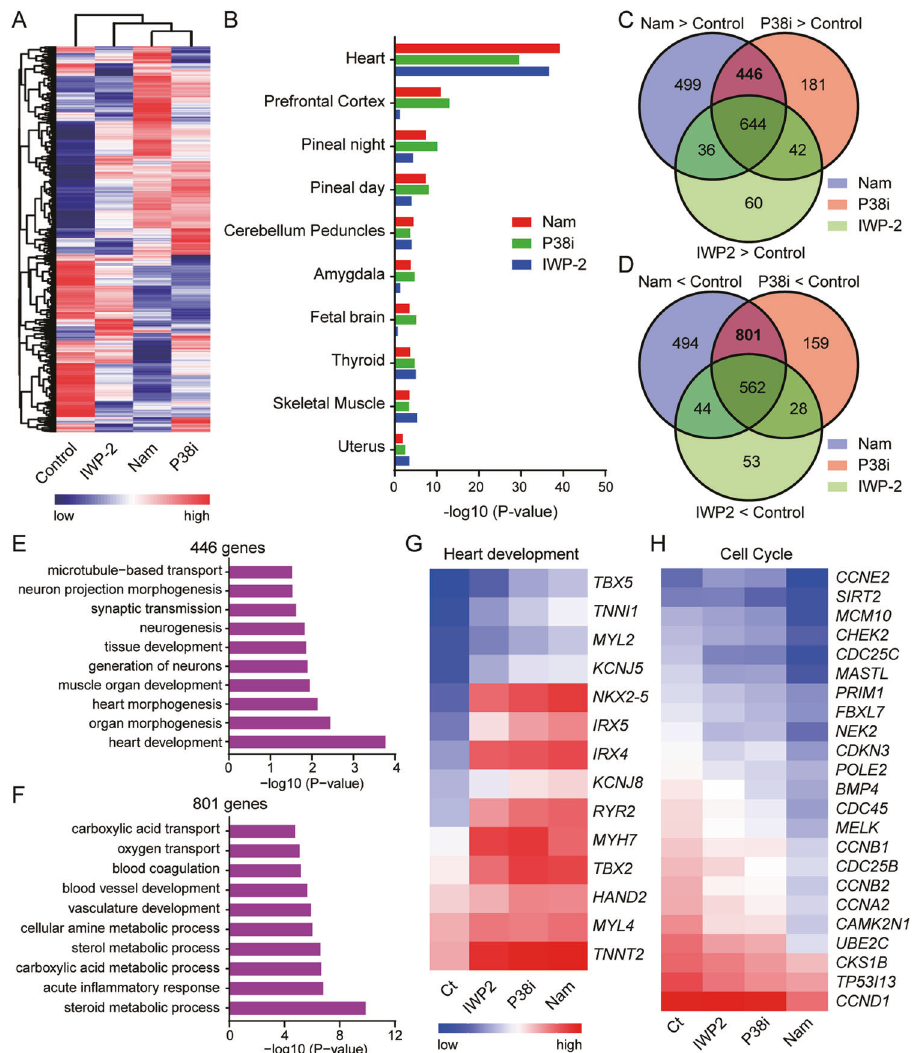
Fig. 5 Comparison of gene expression in cardiomyocytes induced by WNT inhibitor, P38 inhibitor, and nicotinamide. A Hierarchical clustering analyses of differentiated cells with the indicated treatments. IWP-2 at 3 μ M was added from day 2 to day5, and nicotinamide (Nam) at 20 mM or P38 inhibitor SB202190 (P38i) 10 μ M were added from day 1 to day 5. The samples were harvested for microarray after 10 days of differentiation. B Enrichr analysis results showing the top 10 cell types enriched by nicotinamide, P38 inhibitor, or IWP-2 based on gene expression pro fi les. Venn diagram showing the numbers of genes upregulated ( C ) and downregulated ( D ) by nicotinamide (Nam), SB202190, or IWP-2 compared with untreated control. E The top 10 pathways enriched by the 446 genes upregulated by nicotinamide (Nam) and P38 inhibitor (P38i), but not IWP-2. F The top 10 pathways enriched by the 801 genes downregulated by nicotinamide (Nam), or P38 inhibitor (P38i), but not IWP-2. Comparison of gene expression related to heart development ( G ) and cell cycle ( H ) in the differentiated cells generated under different treatments after 10 days of